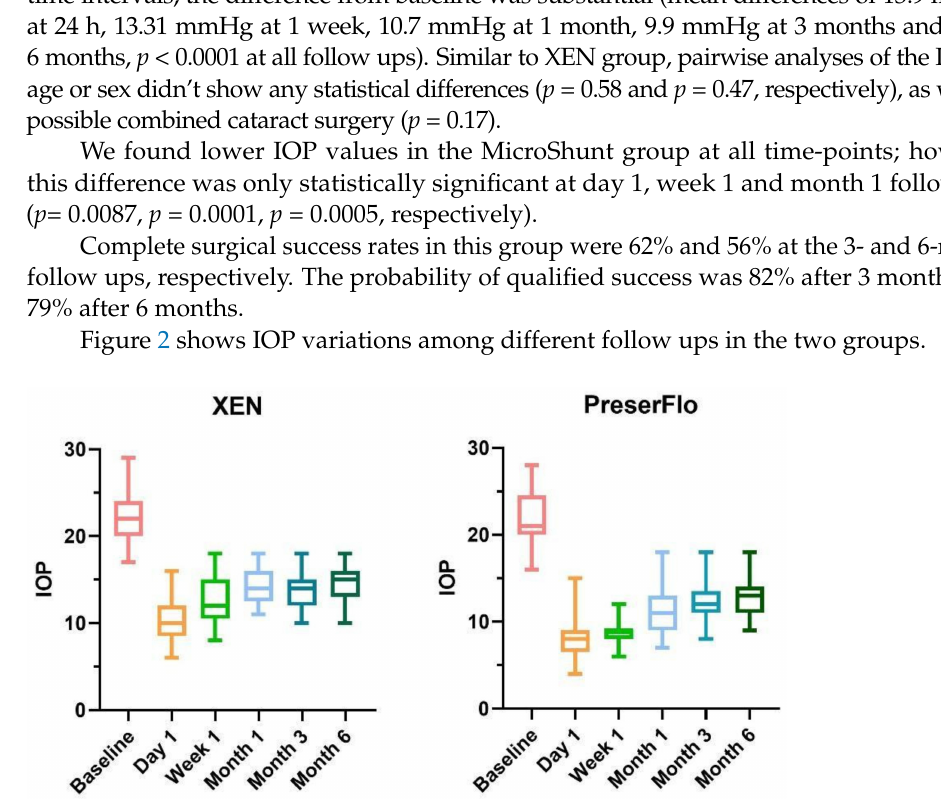
Figure 2. Box and plot diaphgrams of IOP variations in the two subgrops, with indication of every follow up. IOP = intraocular pressure.